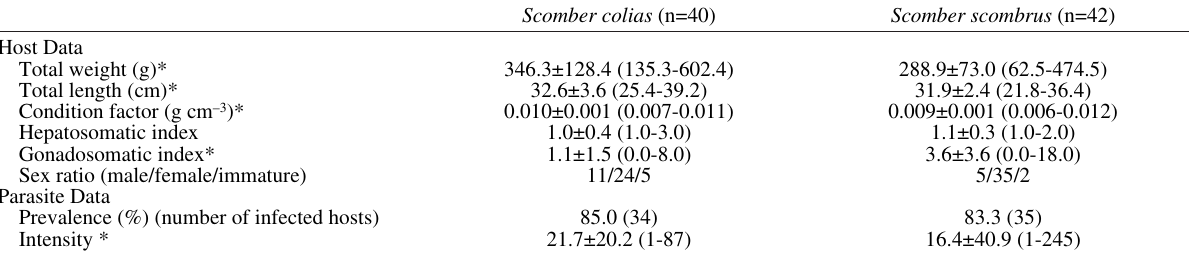
Table 1. – Comparison of host data (total weight, total length, condition factor, hepatosomatic index, gonadosomatic index and sex ratio) and anisakid infection levels (prevalence and intensity) in the Atlantic mackerels, Scomber colias and S. scombrus , off the Portuguese